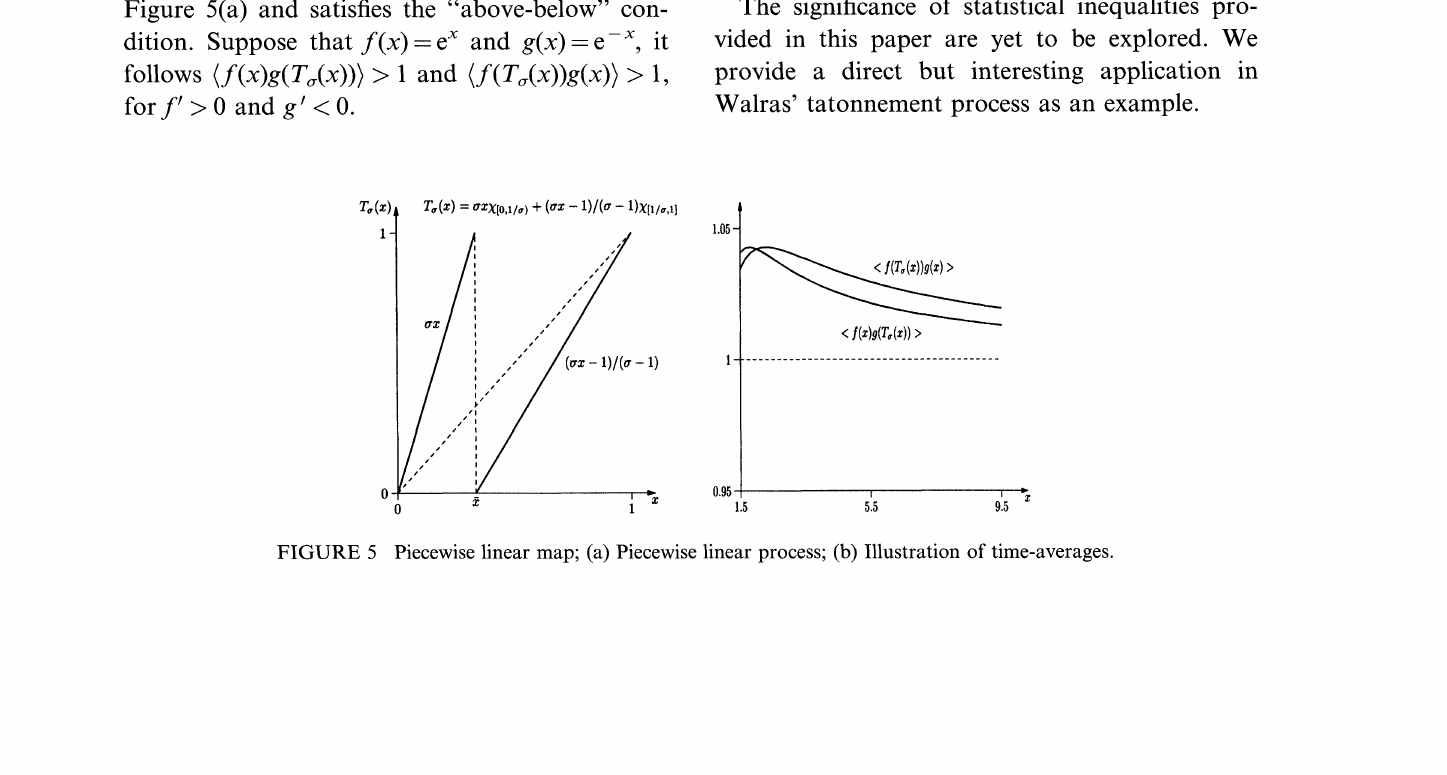
FIGURE 5 Piecewise linear map; (a) Piecewise linear process; (b) Illustration of